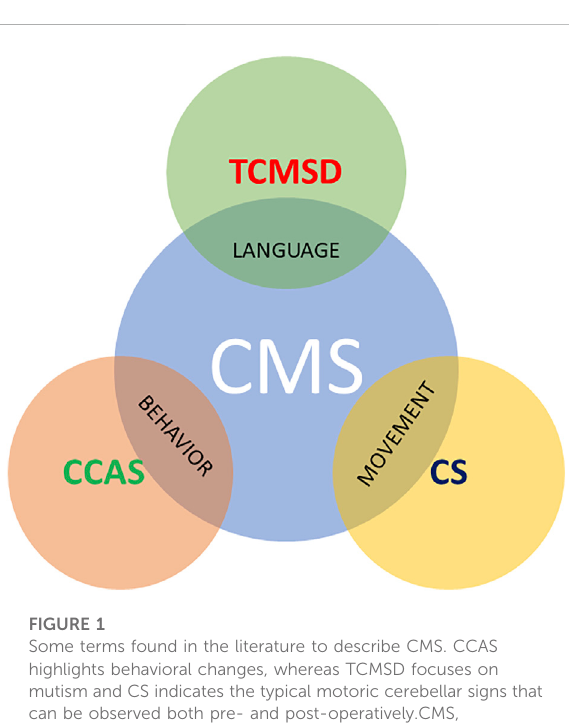
FIGURE 1 Some terms found in the literature to describe CMS. CCAS highlights behavioral changes, whereas TCMSD focuses on mutism and CS indicates the typical motoric cerebellar signs that can be observed both pre- and post-operatively.CMS, cerebellarmutismsyndrome;CCAS,cerebellarcognitive-affective syndrome; TCMSD, transient mutism and subsequent dysarthria; CS, cerebellar